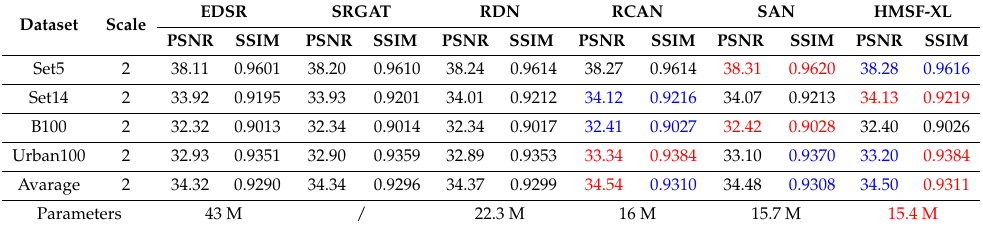
Table 14. We enlarge the HMSF to a large size, and compare it with other state-of-the-art models that have a similar number of parameters. Red/blue text means the best/second-best